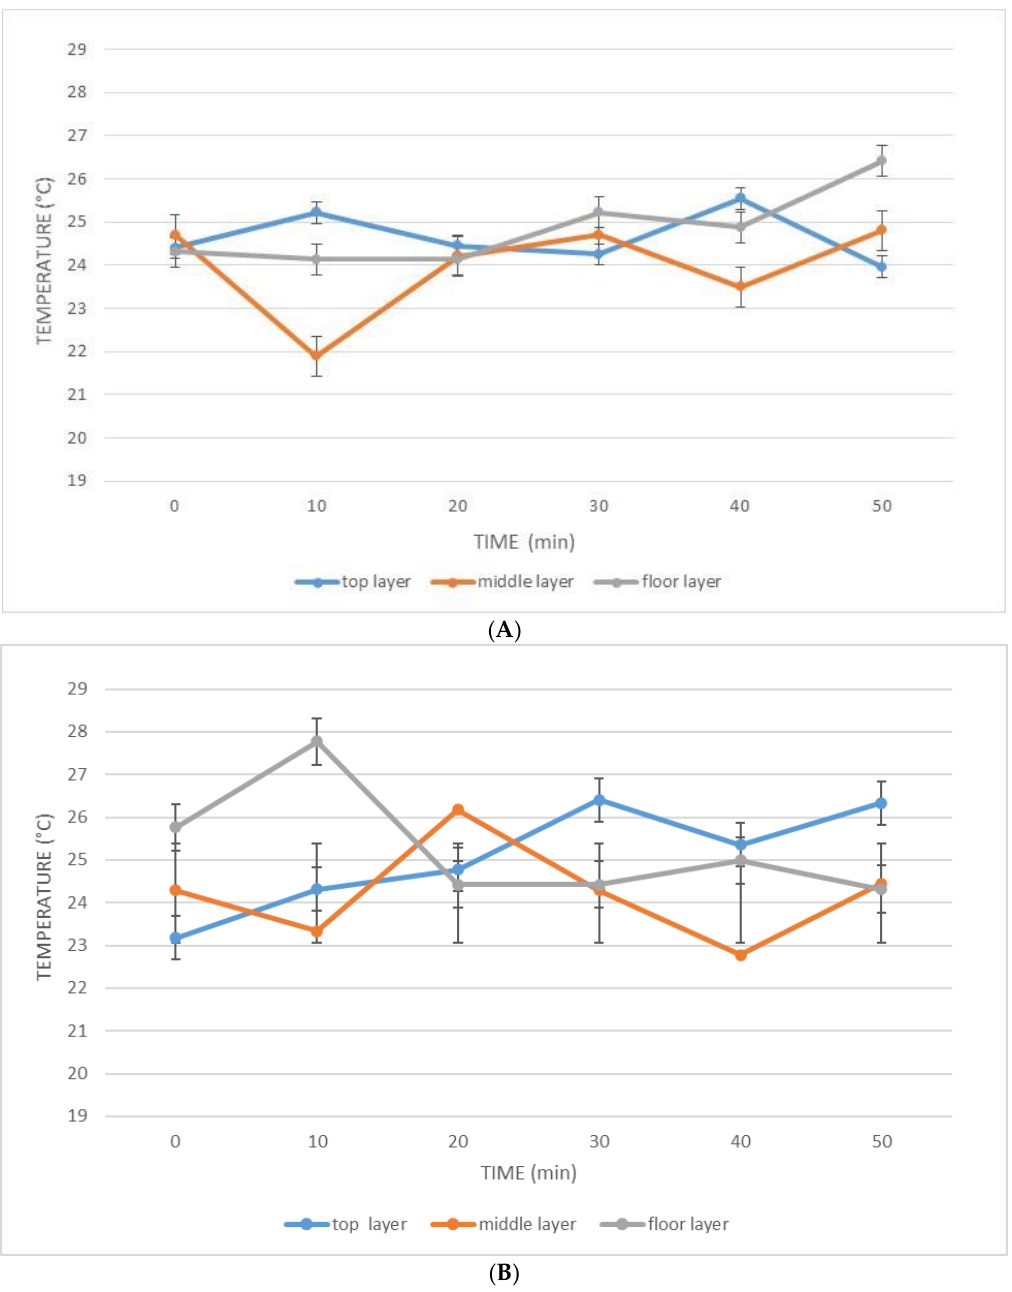
Figure 5 . Distribution over time of the temperature inside the ( A ) unmodified malaxer and ( B ) modified malaxer.